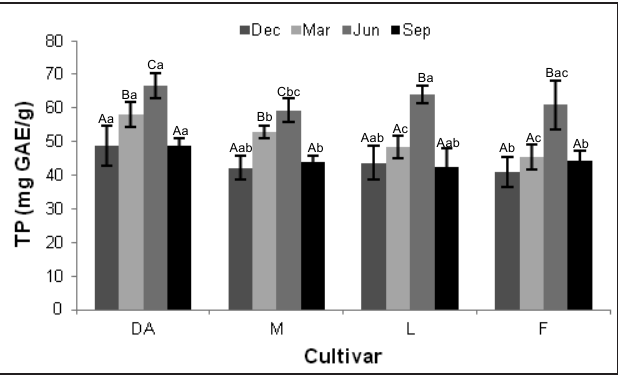
Fig. 4: Total phenol content (mg GAE/g dried leaves, mean values) in Dolce Agogia (DA), Moraiolo (M), Leccino (L), Frantoio (F) olive leaves harvested at December (Dec), March (Mar), June (Jun) and Septem- ber (Sep). Error bars indicate SD of the means (n = 5). Means with different capital letters indicate significant differences ( P ≤ 0.05) among months within the same olive cultivar. Means with different lower case letters indicate significant differences ( P ≤ 0.05) among olive cultivars within the same month.